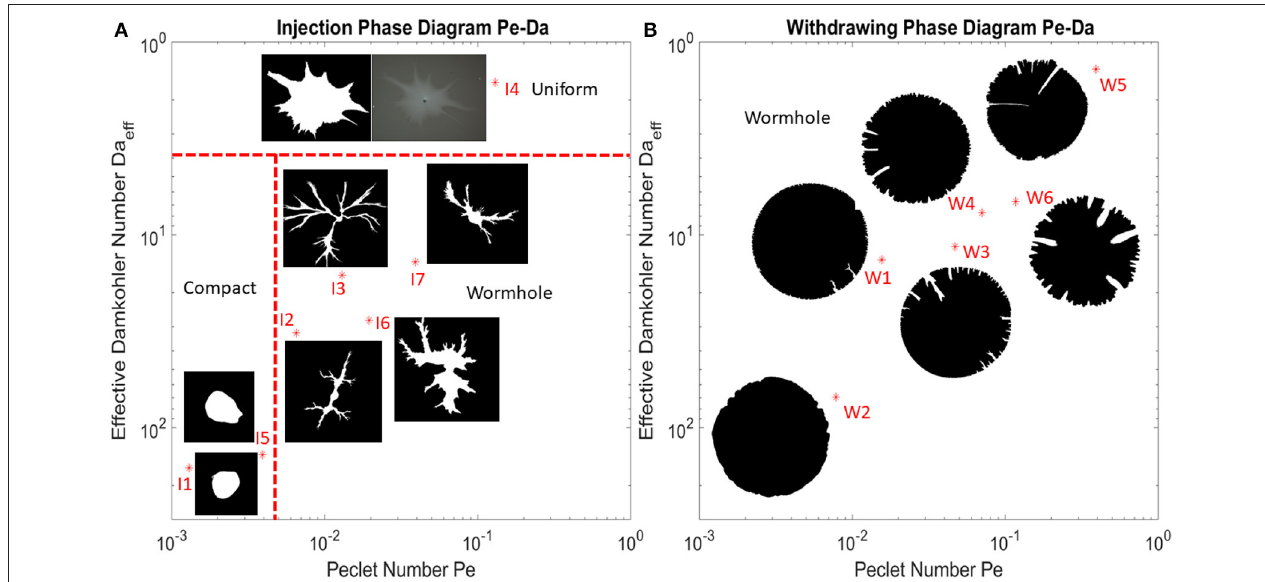
FIGURE 4 | Phase diagram describing characteristic dissolution patterns as a function of Péclet and effective Damköhler number. (A) Phase diagram with flow injected from the center. All the experiments with different Pe and Da eff are marked with red star dots in the diagram, together with the binary image of the final dissolution pattern where the white part indicates dissolved part and the black part indicates undissolved part. The uniform pattern is displayed by both gray-scaled and binarized images in order to demonstrate that the white part at the center is not completely dissolved. The red dashed line represent boundaries between different dissolution pattern regimes. The boundaries between different regimes are drawn based on a qualitative observation of dissolution patterns. (B) Phase diagram with flow withdrawn from the rim of the disk inwards to the central outlet. The compact and uniform dissolution patterns are not clearly experimentally observed in the withdrawing case.